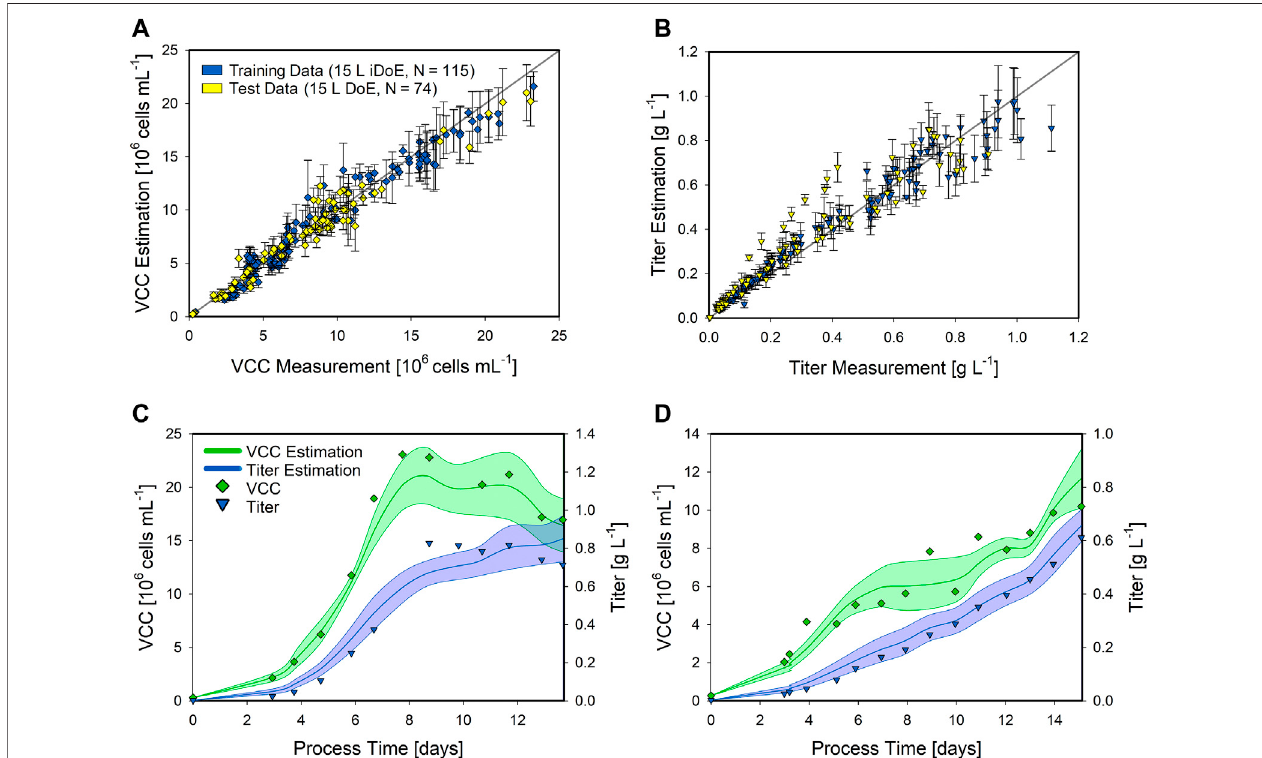
FIGURE 5 | Performance of the 15 L iDoE hybrid model estimating the VCC and product titer of static 15 L bioprocesses. The scatter plots of the hybrid model on the training data (blue) and the test data (yellow) for the VCC (A) and the product titer (B) are presented along with the standard deviation as error bars. Detailed time- resolved model estimations are presented for two static DoE bioprocesses (C,D) . The model estimations for the VCC (green lines) and product titer (blue lines) are indicated along with the respective CI (shaded area). The analytical measurements are given for the VCC (green squares) and the product titer (blue